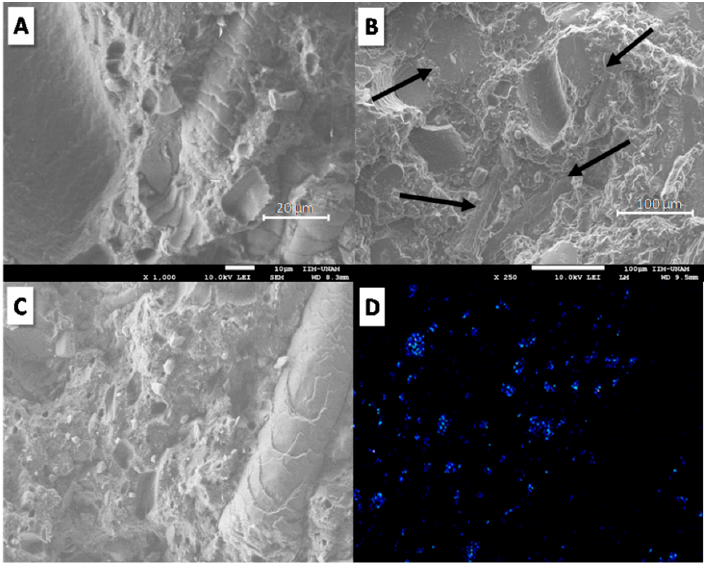
Figure 4. SEM micrographs of the fractured surface of TPS/20KF/10APP at two different magnifications ( A , B ). Elemental analysis of TPS/20KF/10APP: ( C ) scanned area and ( D ) phosphorus mapping.